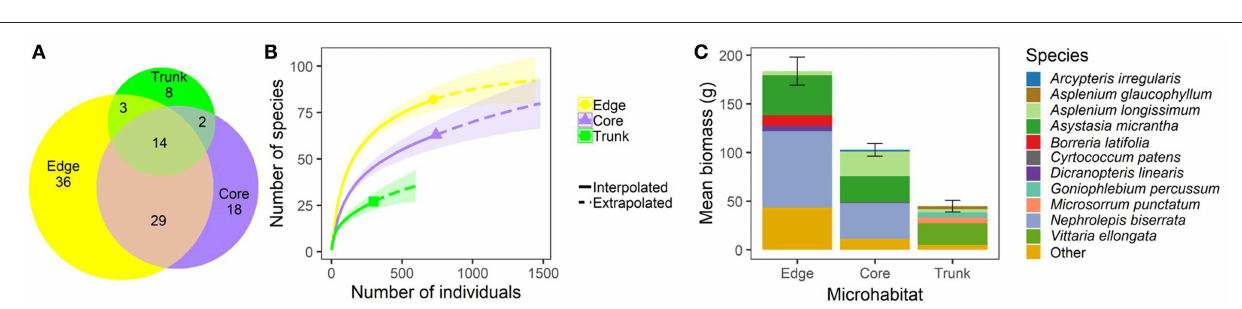
FIGURE 2 | Plant community composition within different microhabitats (understory at plot edge, “Edge”; understory at plot core, “Core”; and oil palm trunk, “Trunk”) within BEFTA Understory Vegetation Project experimental plots during the pre-treatment phase of the experiment. During this time, all plots were being managed using business-as-usual vegetation management practices (Normal vegetation). Panel (A) shows the total number of plant species found within, and shared between, different microhabitats. Note that the collection effort was double in the Core plots compared to Edge and Trunk. Note also that the species total reported here (110) does not match the grand total from the whole study (120) because only pre-treatment data are used in this figure. Panel (B) shows interpolated and extrapolated species accumulation curves for the different microhabitats. Panel (C) shows the relative dominance of different plant species within each microhabitat by showing the total mean plant biomass ( ± SE) per 1m 2 quadrat split across the five most dominant (by biomass) plant species, and “Other” plant species. The species name “ Asystasia gangetica subsp. micrantha” has been shortened to Asystasia micrantha within the figure. We have included a colour blind friendly version of this figure in Supplementary Materials